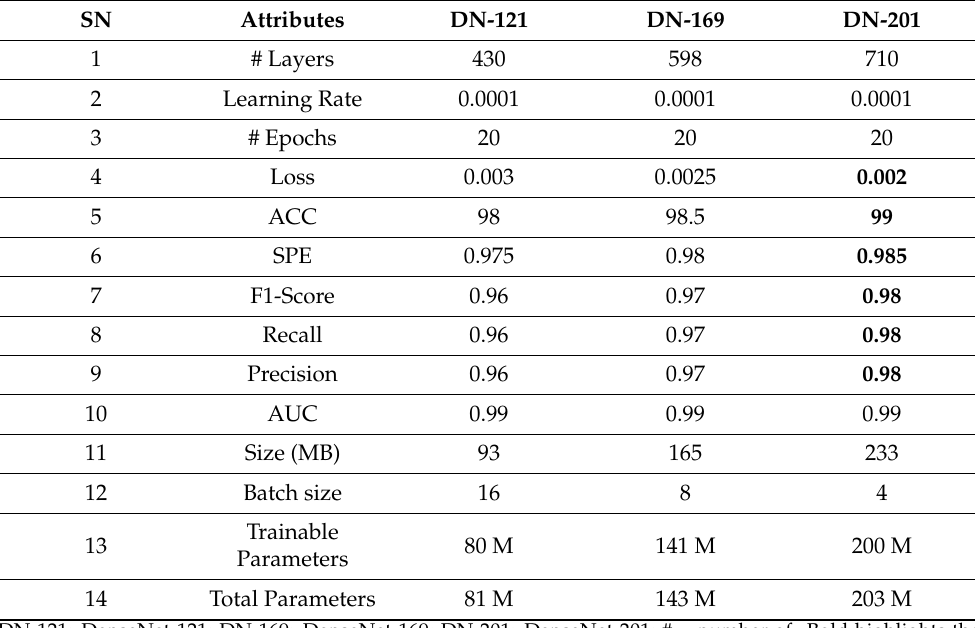
Figure 8. Heatmap using four CAM techniques using three kinds of DenseNet classifiers on COVID- 19 lesion images. 19 lesion images. Table 3. Comparative table for three kinds of DenseNet classifier